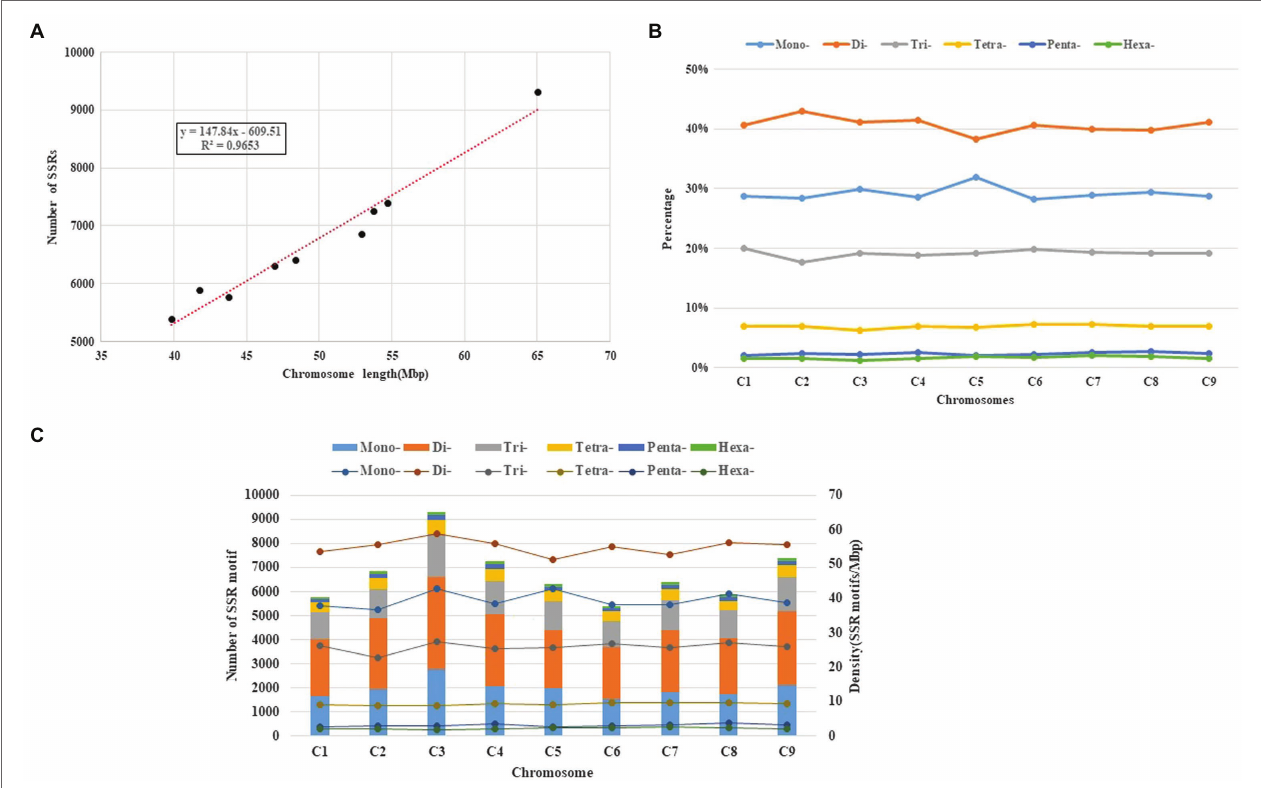
FIGURE 4 | Intra-chromosomal distribution of SSRs. (A) Relationship between the SSR number and chromosome length in the cabbage genome. (B) The frequency of mono- to hexanucleotide motifs in cabbage chromosomes. (C) Number and density of the SSR motifs across nine chromosomes of the cabbage reference genome.